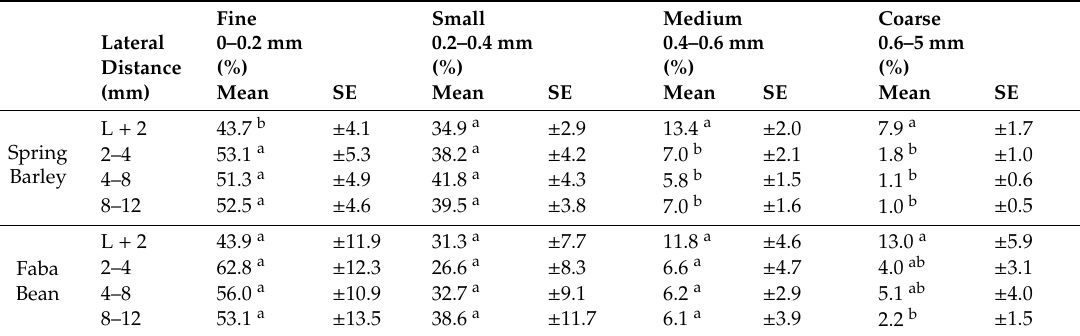
Table 2. Proportion of root length (%) categorized in diameter classes (mm) of spring barley and faba bean. Mean and SE of lumen + 2 mm (L + 2) and the distances from macropore. Means not sharing a common letter indicate significant di ff erences between the distances from macropore within one depth interval (Tukey HSD, α = 0.05).